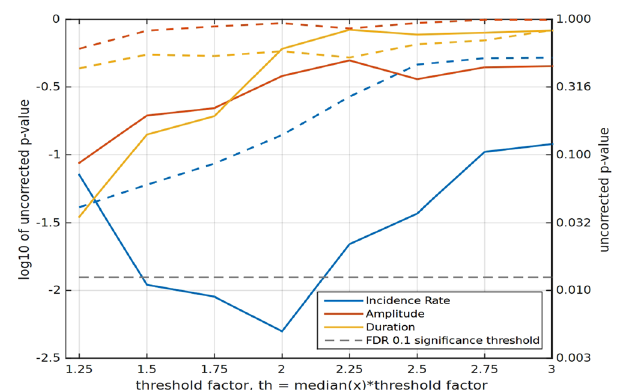
Figure 5. The effect of varying the spindle detection threshold. The p –value for the three parameters (spindle amplitude, incidence rate and duration) calculated from P4 electrode data for different threshold values is shown. The dashed lines correspond to the sham feedback group and the solid lines to the experimental group. The observed significance of alpha spindles incidence rate increase persists for a large range of threshold